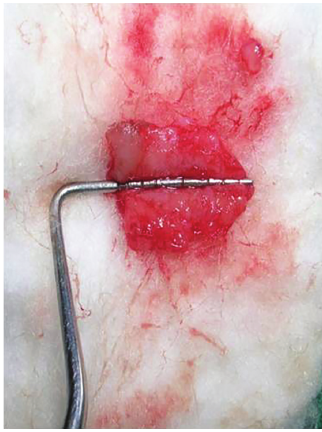
Figure 7: Harvested free connective tissue graft.